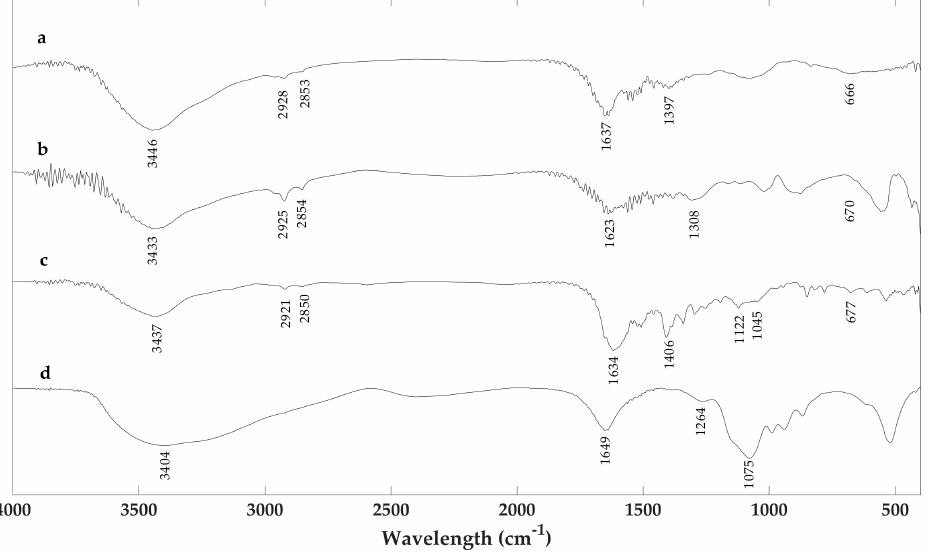
Figure 3. Fourier-transform infrared (FTIR) spectra of (a) Sc-Ms1 melanin, (b) Sc-Ms1 tyrosinase dopa-melanin, (c) Tv laccase cysteinyldopa melanin, and (d) Tv laccase dopa-melanin. All spectra were recorded in transmittance mode.